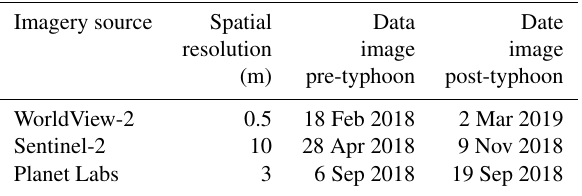
Table 2. Details of the satellite imagery sources used in this